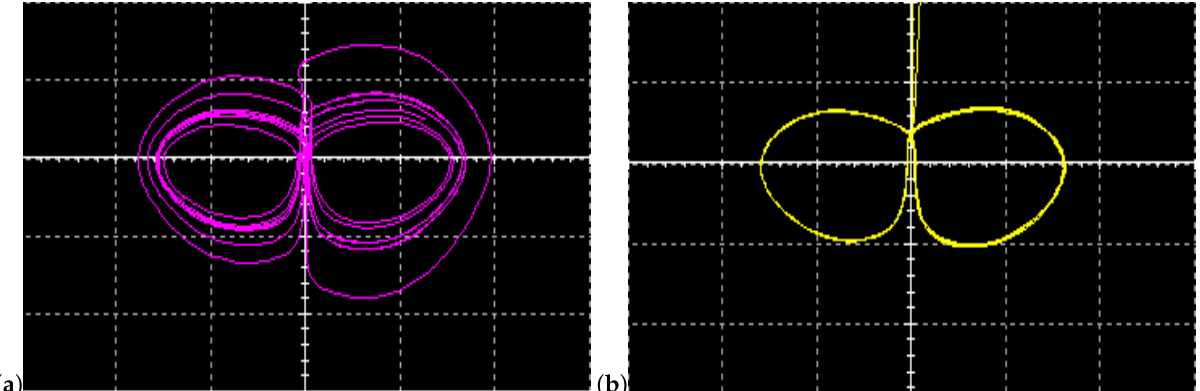
Figure 21. Phase portraits of coexisting attractors in Multisim of the circuit with a = 10, b = 12, c = 2.7, k = − 0.2, and m = 1: ( a ) hidden chaotic attractor; ( b ) hidden periodic attractor. Scales of horizontal and vertical axes are 5 and 2 V/div,